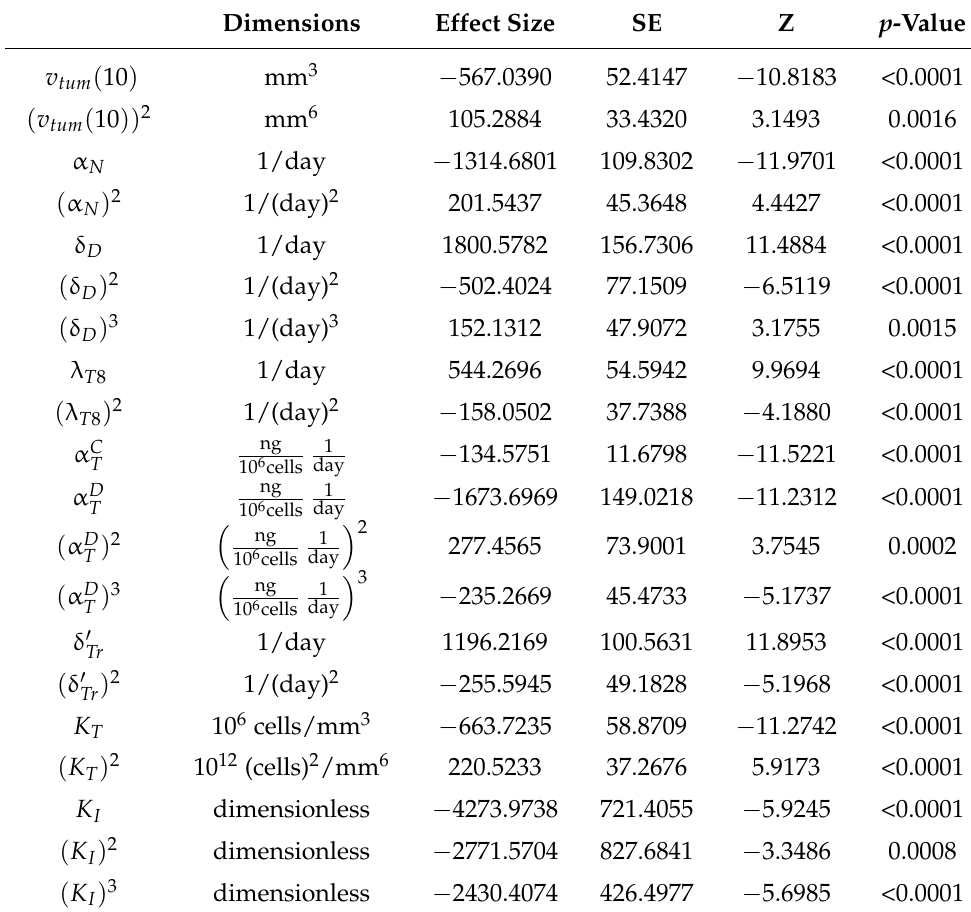
Table 1. For each parameter, including higher-order terms where significant: the Dimensions of the parameter, the Effect Size (on a logistic scale, per unit), the standard error in the estimate of the effect size (SE), the corresponding Z score and p -value from the multiple logistic